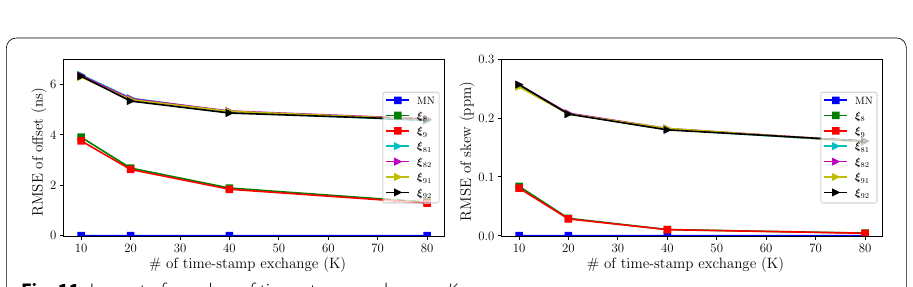
Fig. 11 Impact of number of time-stamp exchanges K